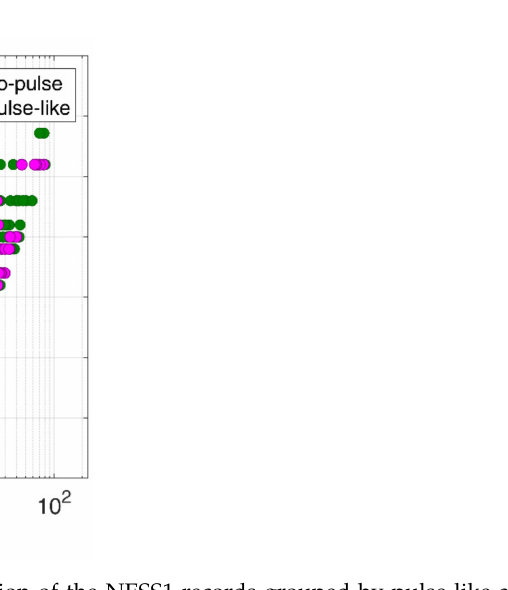
Figure 1. Magnitude-distance distribution of the NESS1 records grouped by pulse-like and no- pulse